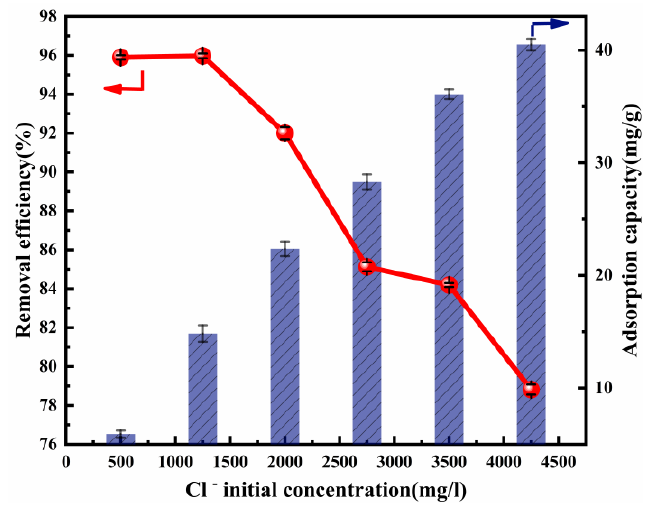
Figure 4. Cl − removal efficiency and adsorption capacity as a function of the Cl − initial concentration (ion ratio Mg: Al = 6:1; adsorbent dose: 2 g; adsorption temperature: 293 K; contact time:13 h).